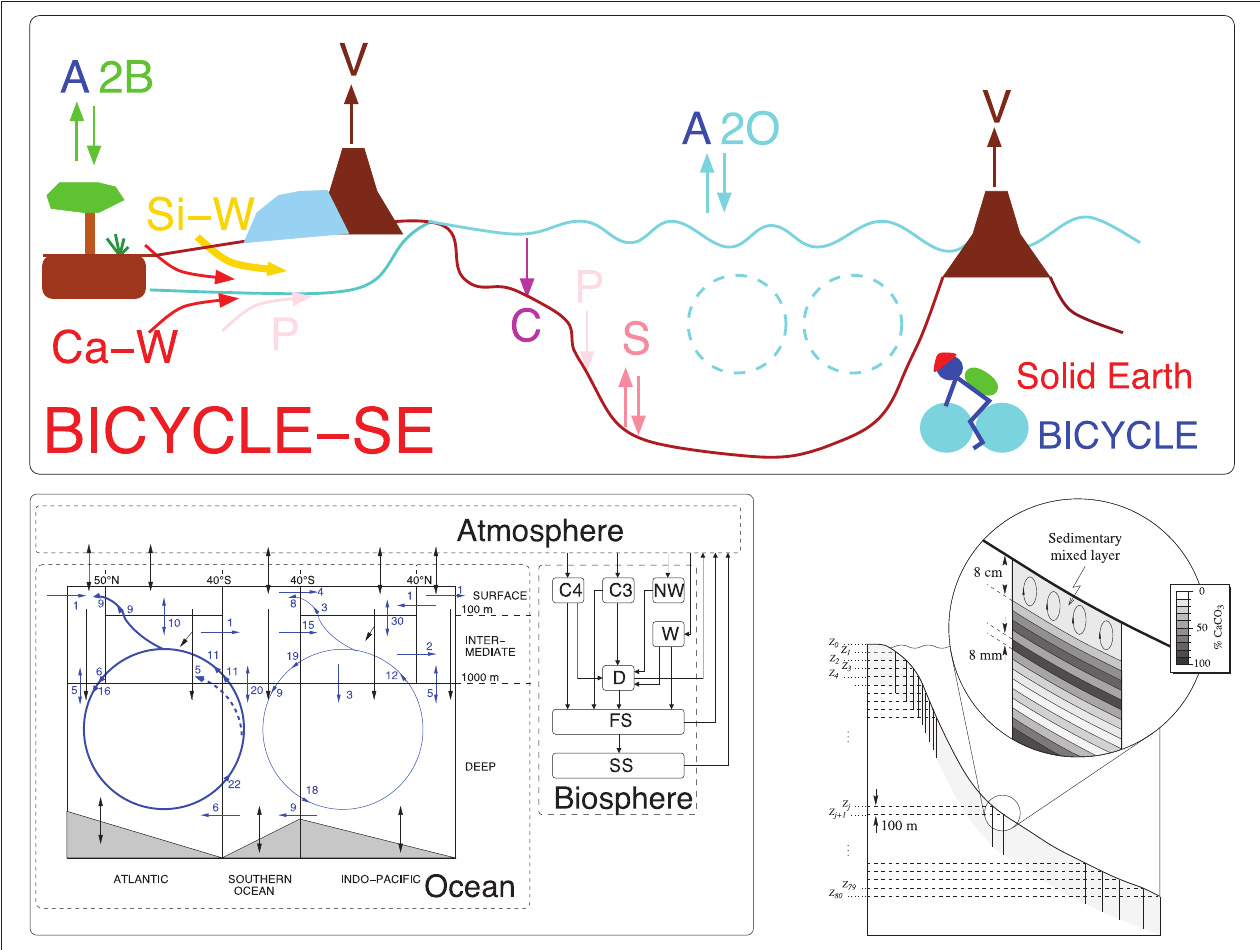
FIGURE 1 | Sketch of the BICYCLE model. Top: Model version including solid Earth fluxes (BICYCLE-SE) explained in detail in Köhler and Munhoven (2020). V: Outgassing of CO 2 from volcanoes on land potentially and temporally overlain by land ice and from hot spot island volcanoes (and mid ocean ridges, not shown) on paleo-time scales influenced by a changing sea level, but kept constant for the future scenarios investigated here; C: shallow water carbonate deposition due to coral reef growth; Si-W: silicate weathering; and Ca-W: carbonate weathering with different sources of C, but both delivering HCO − 3 -ions into the ocean; P: PO 3 − 4 riverine input and sedimentary burial; S: CaCO 3 sedimentation and dissolution. A2B: atmosphere-biosphere exchange of CO 2 ; A2O: atmosphere-ocean exchange of CO 2 . The cyan-colored broken circles mimic the two overturning cell in the Atlantic and Indo-Pacific Ocean. The model versions without solid Earth processes have been restricted to the fluxes A2O, A2B, and some simplified representation of carbonate compensation between ocean and sediment. Bottom left: Details of subsystem AOB (adopted from Köhler et al., 2010a) with the fixed prescribed pre-industrial water fluxes in the ocean (blue, numbers given in Sv). Black arrows denote carbon fluxes. Boxes in the land biosphere: C4, C 4 ground vegetation; C3, C 3 ground vegetation; NW, non-woody parts of trees; W, woody parts of trees; D, detritus; FS, fast decomposing soil; SS, slow decomposing soil. Bottom right: A conceptual sketch of the sediment module, the figure is taken from Munhoven